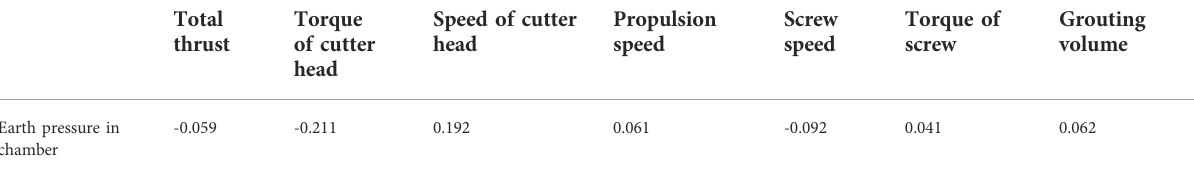
TABLE 2 Pearson correlation coef fi cient between chamber Earth pressure and excavation